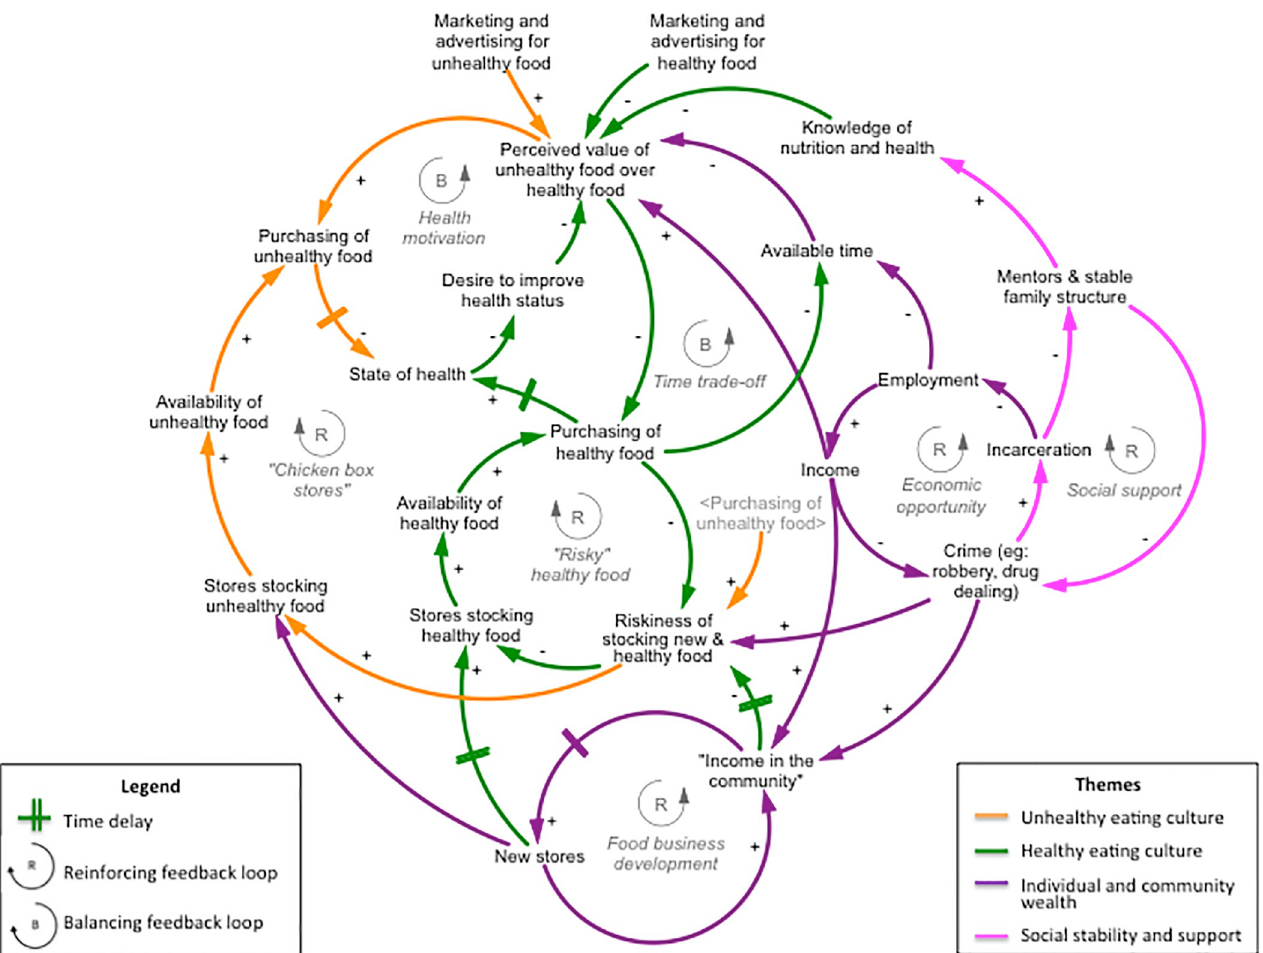
Fig 1. Themes and feedback loops in the synthesized causal loop diagram, initiated around the question, “What affects access to fresh and affordable food in Central West Baltimore?” � . � Solid lines with positive polarity (+) represent a relationship that can interpreted in two ways: increase in a factor causes an increase in the receiving factor, and a decrease in a factor causes a decrease in the receiving factor; solid lines with negative polarity (-) represent a relationship that can be interpreted in two ways: increase in a factor causes a decrease in the receiving factor, and a decrease in a factor causes an increase in the receiving